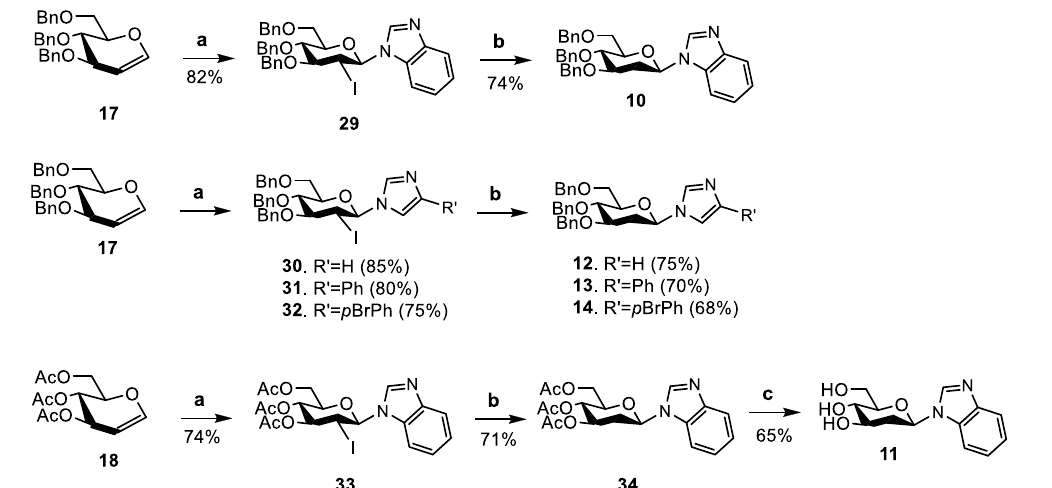
Scheme 5. Preparation of 2-deoxy- β - D -glycosylimidazoles. Reagent and conditions: (a) NIS/imidazole/propionitrile/reflux/2 h; (b) Bu 3 SnH/AIBN/toluene/reflux/2 h; (c) NaOCH 3 /CH 3 OH.